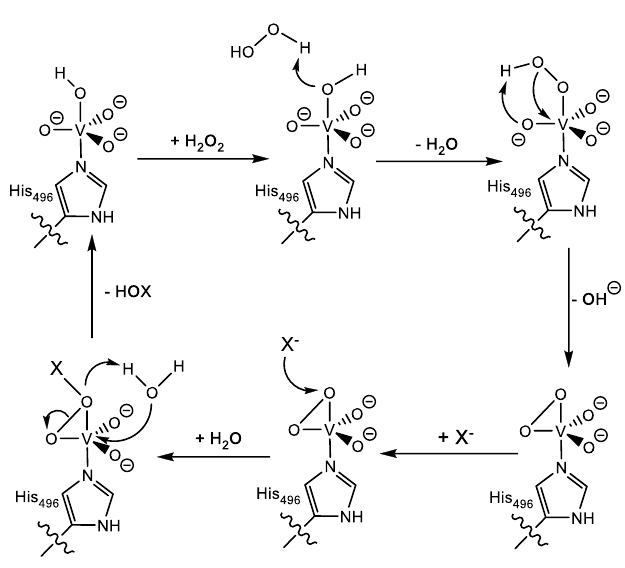
Figure 6. Proposed catalytic cycle of V-XPO.